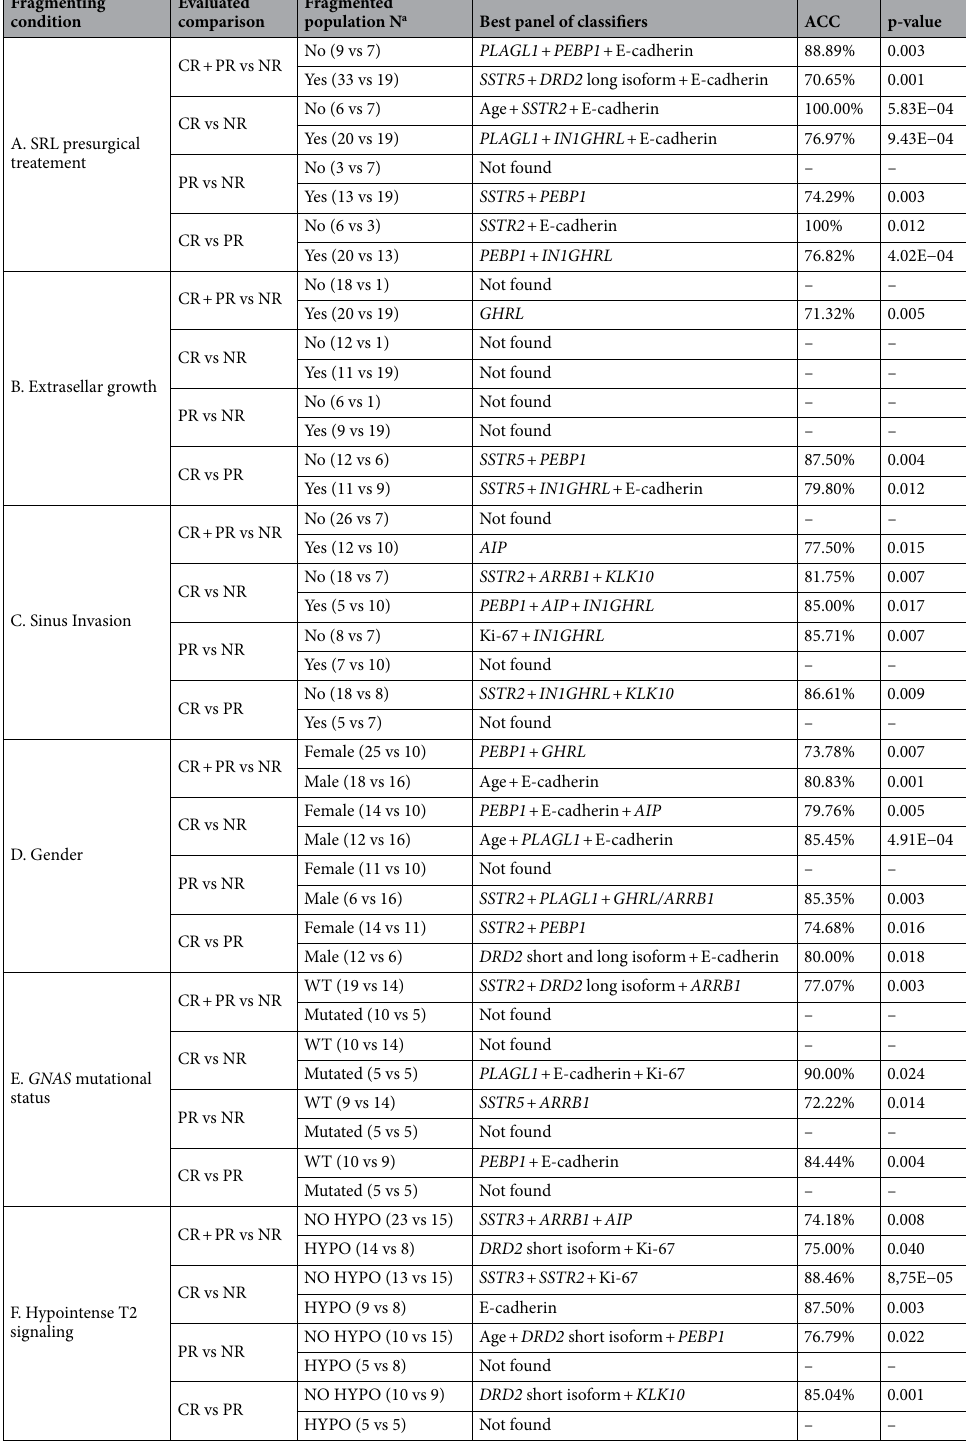
Table 5. Best classifiers in patients with or without SRL presurgical treatment, extrasellar growth, sinus invasion, biological sex and GNAS mutational status. For each subgroup, the best panel/s of classifiers (with accuracy higher than the maximal one achieved by the classifiers using the whole cohort without fragmentation) in each comparison are shown. a The third column refers to the condition in the first column. ACC